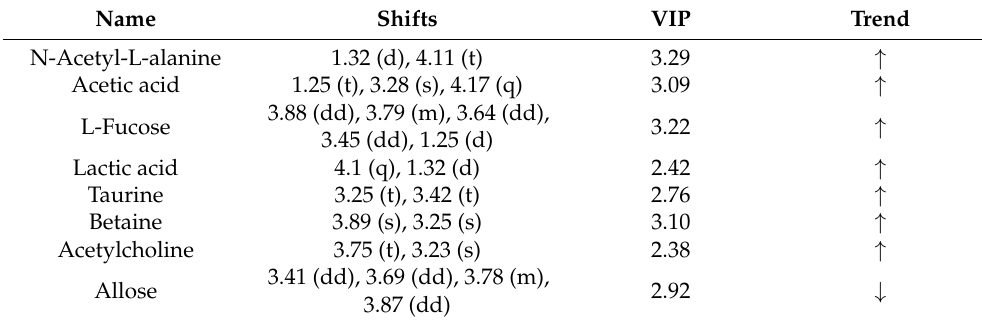
Table 2. Differently expressed metabolites in the DSS group compared with the HC